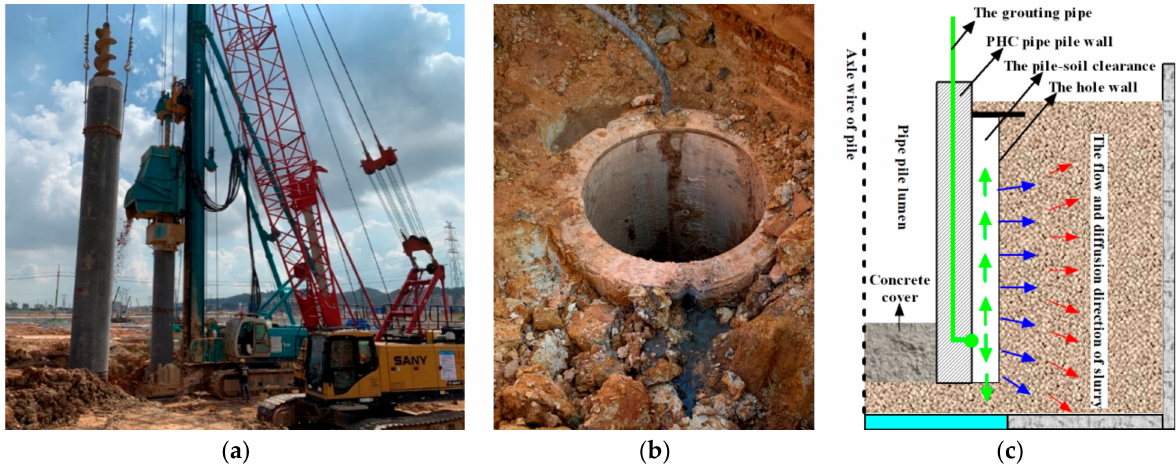
Figure 1. Physical diagrams of the orthogonal test. ( a ) Uniaxial compressive strength test; ( b ) fluidity test; ( c ) volume growth rate of the grouting body